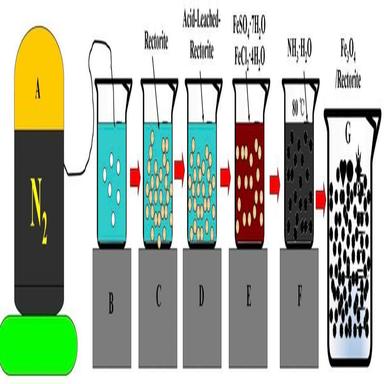
Preparation of Fe3O4/rectorite and nano-Fe3O4.